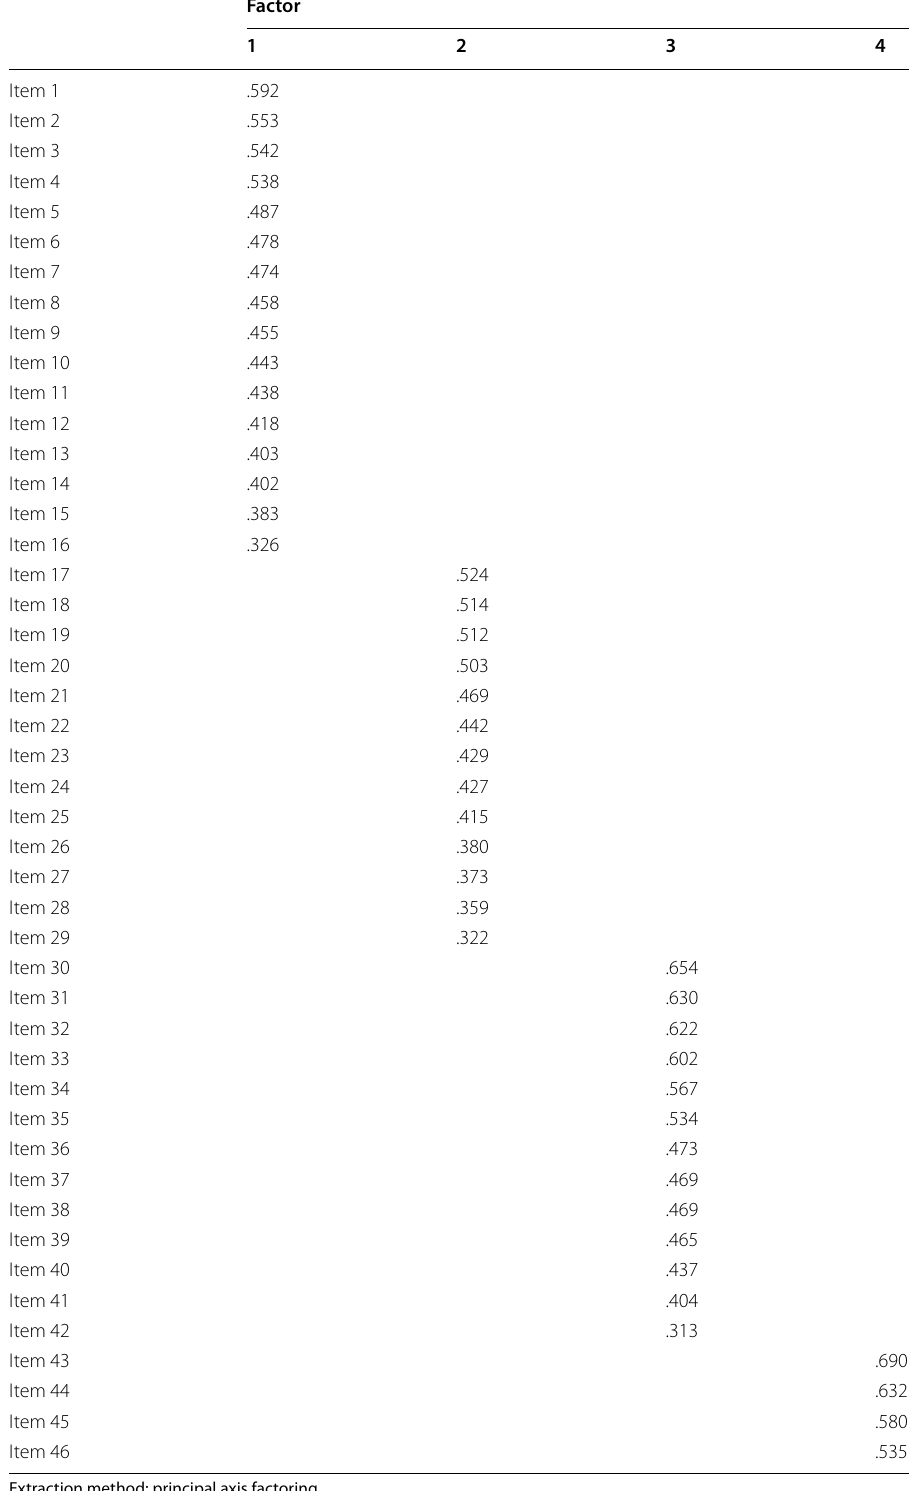
Table 5 Structure matrix of the sources of unreliability of test